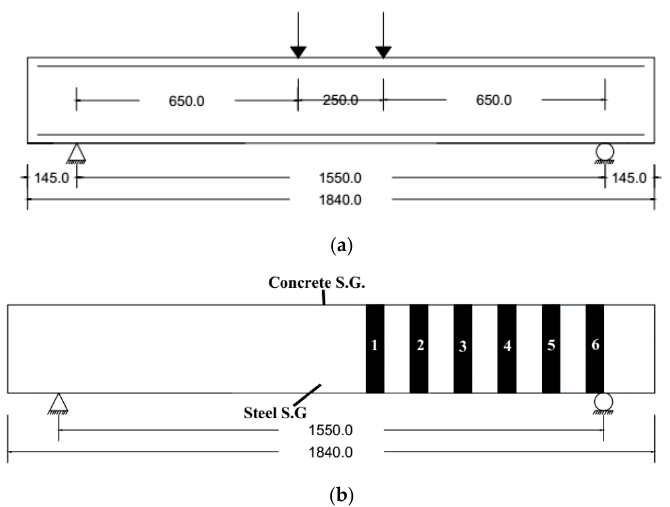
Figure 5. Test setup and instrumentations (all dimensions are in mm): ( a ) Loading setup; ( b ) Strain gauges location. Materials 2020 , 13 , x FOR PEER REVIEW